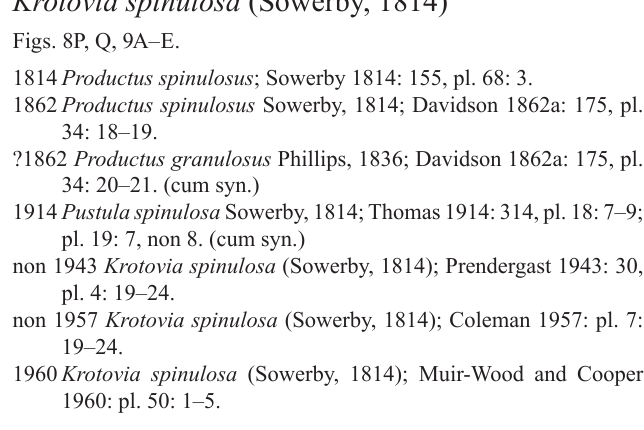
Description .—Small, concavo-convex shell with trans- versely suboval outline; cardinal margin wide; maximum width attained at one-third shell length. Ears small, flat. Corpus cavity shallow. Anterior commissure rectimargin- ate. Dorsal valve strongly concave. Fold and sulcus absent. Trail